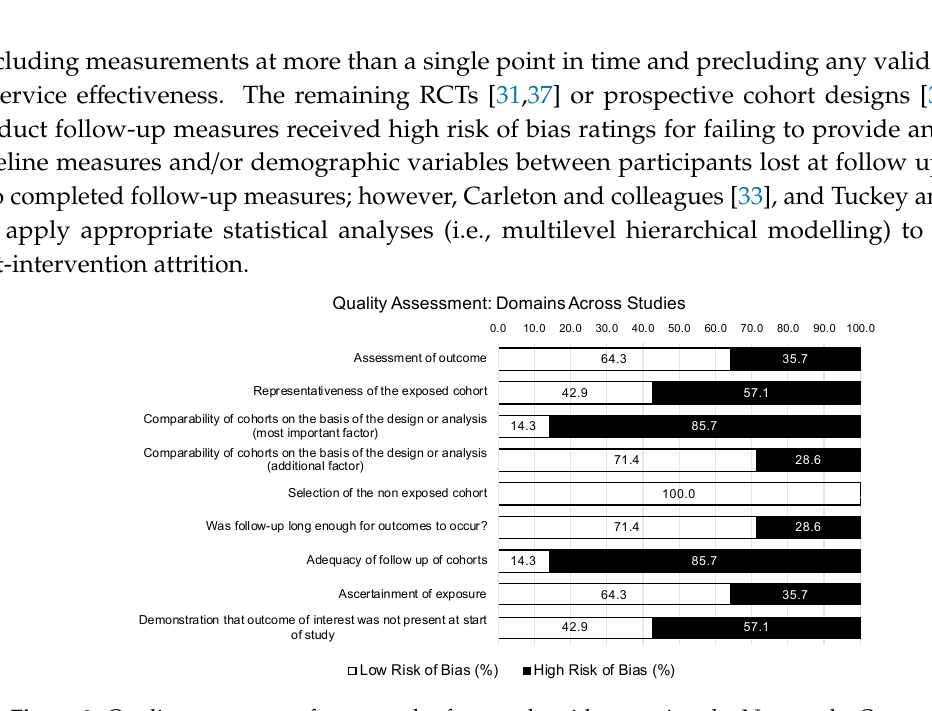
Figure 2. Quality assessment for strength of research evidence using the Newcastle–Ottawa quality assessment scale for cohort studies—full sample summary ( n = 14 studies).